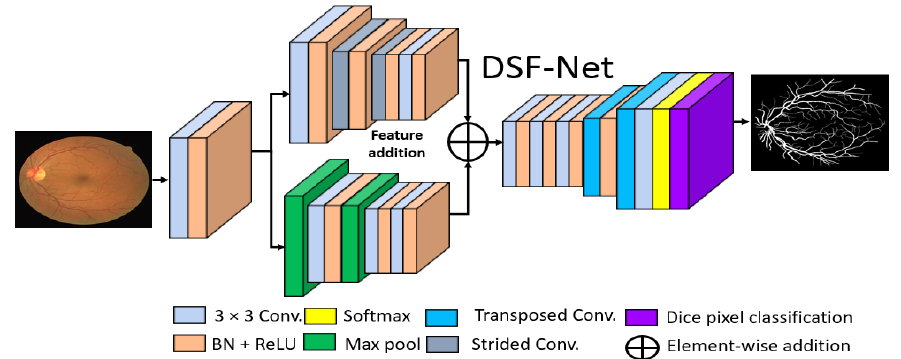
Figure 5. Proposed Dual-Stream Fusion Network (DSF-Net) Abbreviations: DSF-Net, dual stream fusion network, Conv., convolution, BN, batch normalization, ReLU, rectified linear unit.